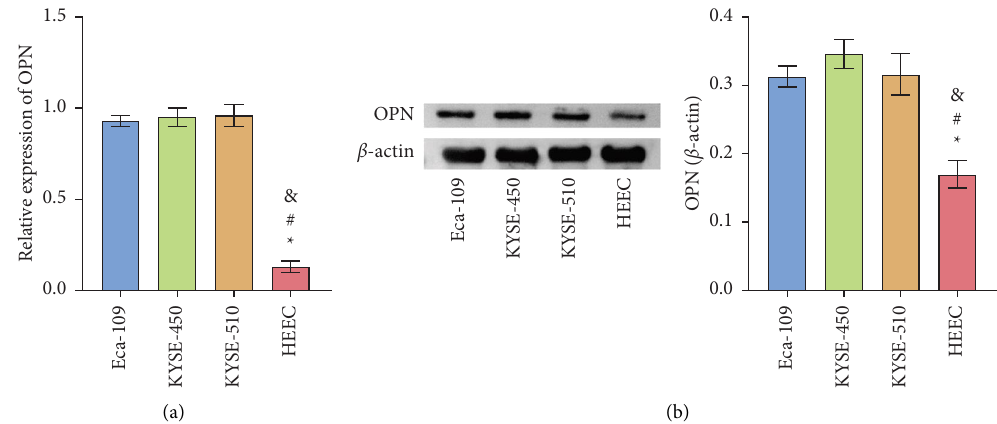
Figure 1: Expression of OPN in the Eca-109, KYSE-450, KYSE-510, and HEEC. (a) Te mRNA of OPN was detected by qRT-PCR. (b) Te protein of OPN was measured by western blot. ∗ P < 0 . 05 compared with Eca-109, # P < 0 . 05 compared with KYSE-450, & P < 0 . 05 compared with